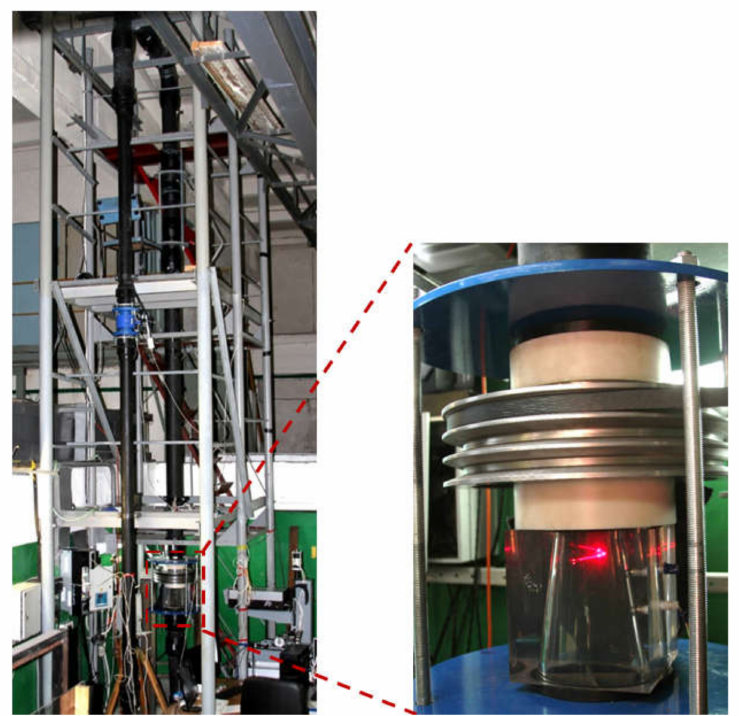
Figure 1. Photo of the experimental setup. The main flow direction is downwards. The runner is rotated clockwise viewed from the top. Turbine runner rotational speed n is up to 3000 r/min.